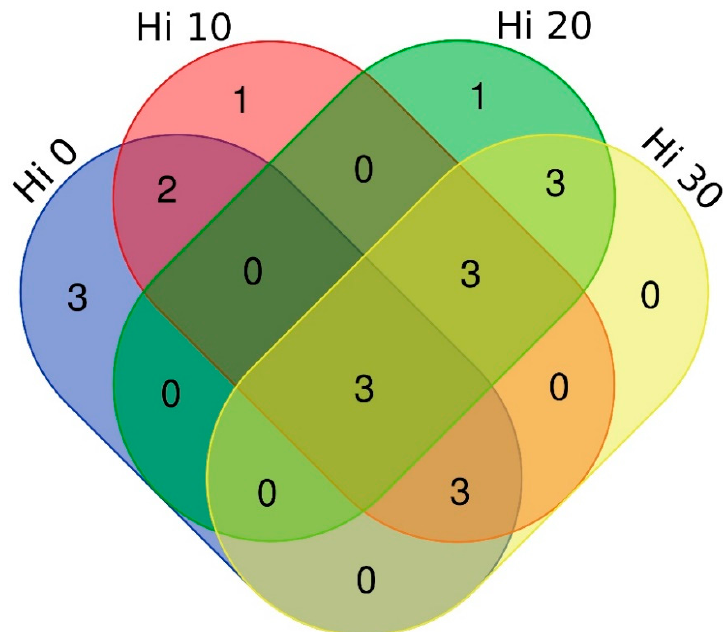
Figure 1. Venn diagram representing unique and shared Operational Taxonomic Units (OTUs) among all dietary groups. The core microbiome was defined as the OTUs present in 80% of the samples regardless of diet.